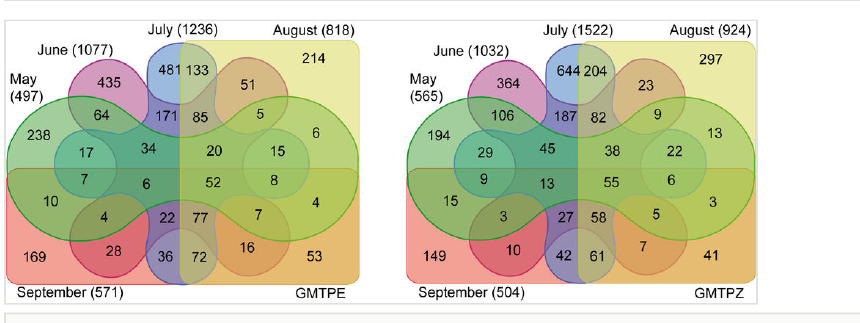
Figure 3. Total number of BINs per month (in parentheses), private BINs per month (in non-overlaid colored fi elds), and BIN overlap during the course of the summer and between months. For example, the highest number of private BINs not present in any other month occurred in July (481 & 644), while the highest number of shared BINs occurred between June and July (171 & 187) and the number of BINs present throughout the sampling period was 52 and 55; GMTPE left and GMTPZ